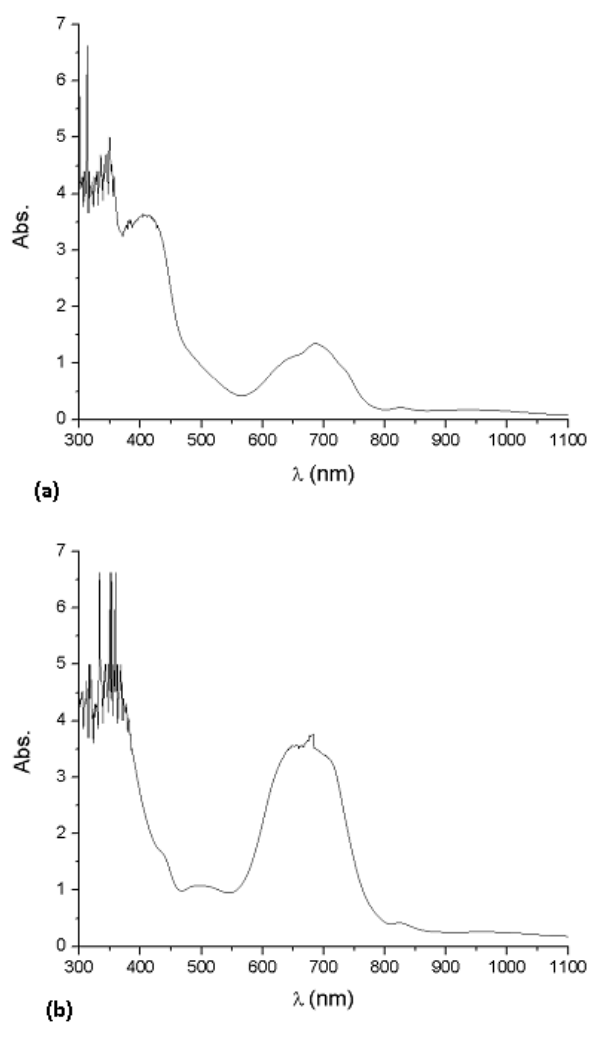
Figure 5. Absorption spectra of the ( a ) Li 6447 Å thicknesses,